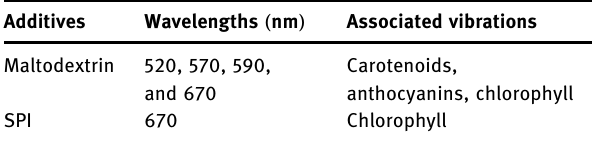
Table 1: Wavelength of peaks and associated vibrations Additives